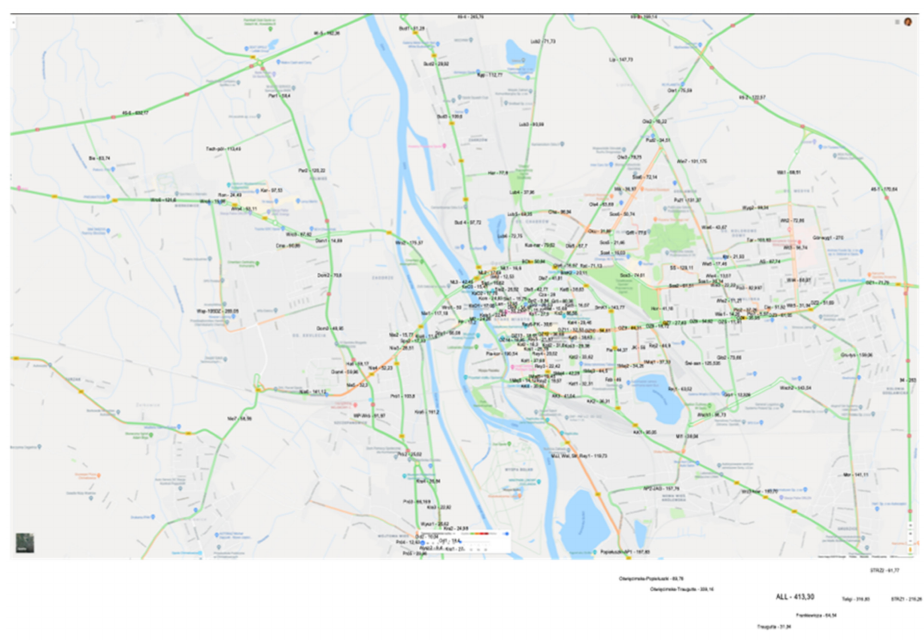
Figure 3. Stage 1—Allocation of average travel time to road sections. Source: Google